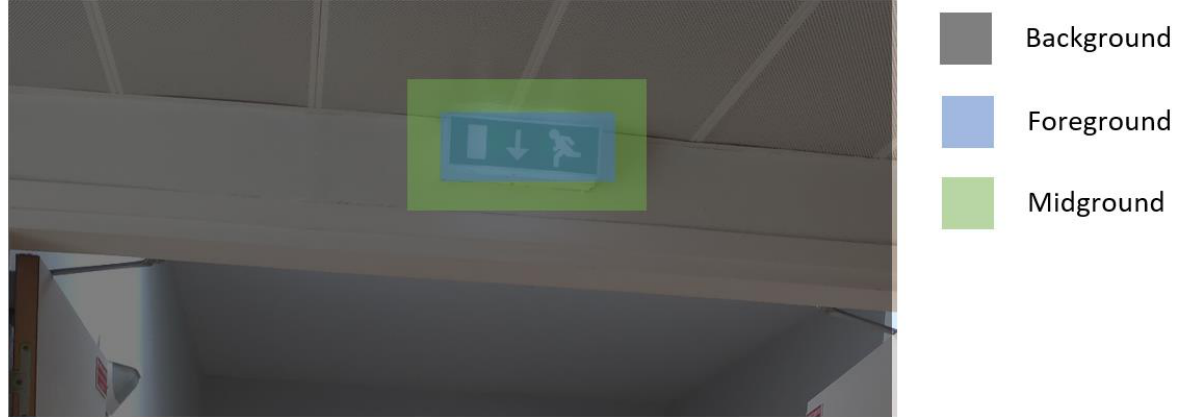
Figure 2. Presentation of background, foreground, and midground in the